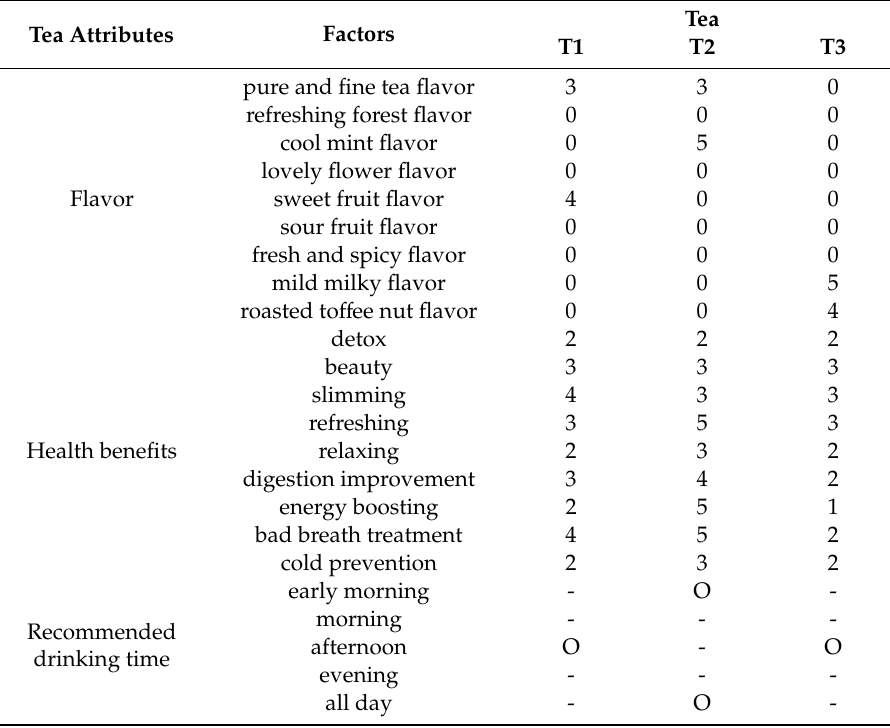
Table 1. Tea attribute database